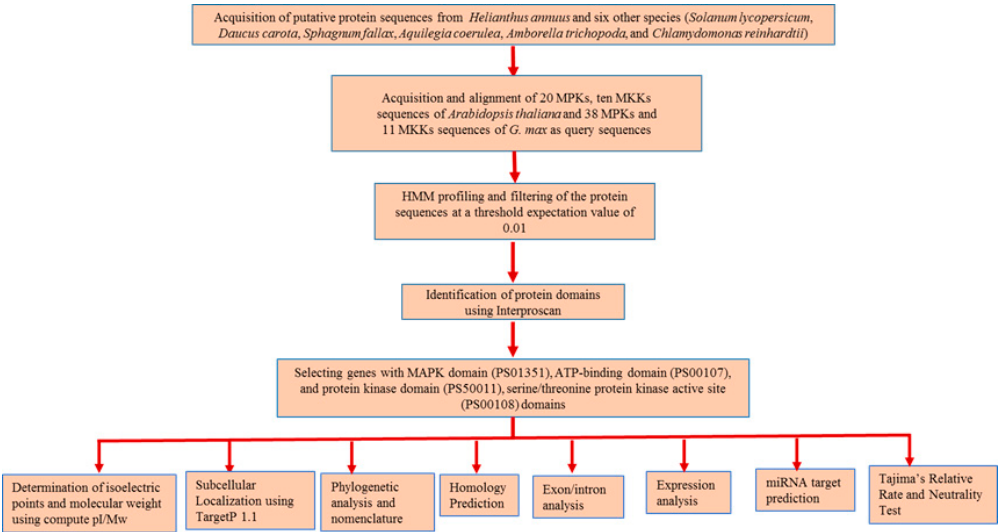
Figure 1. Schematic representation of in silico approaches used in the identification of MPK and MKK genes in seven plant species and their downstream analyses.